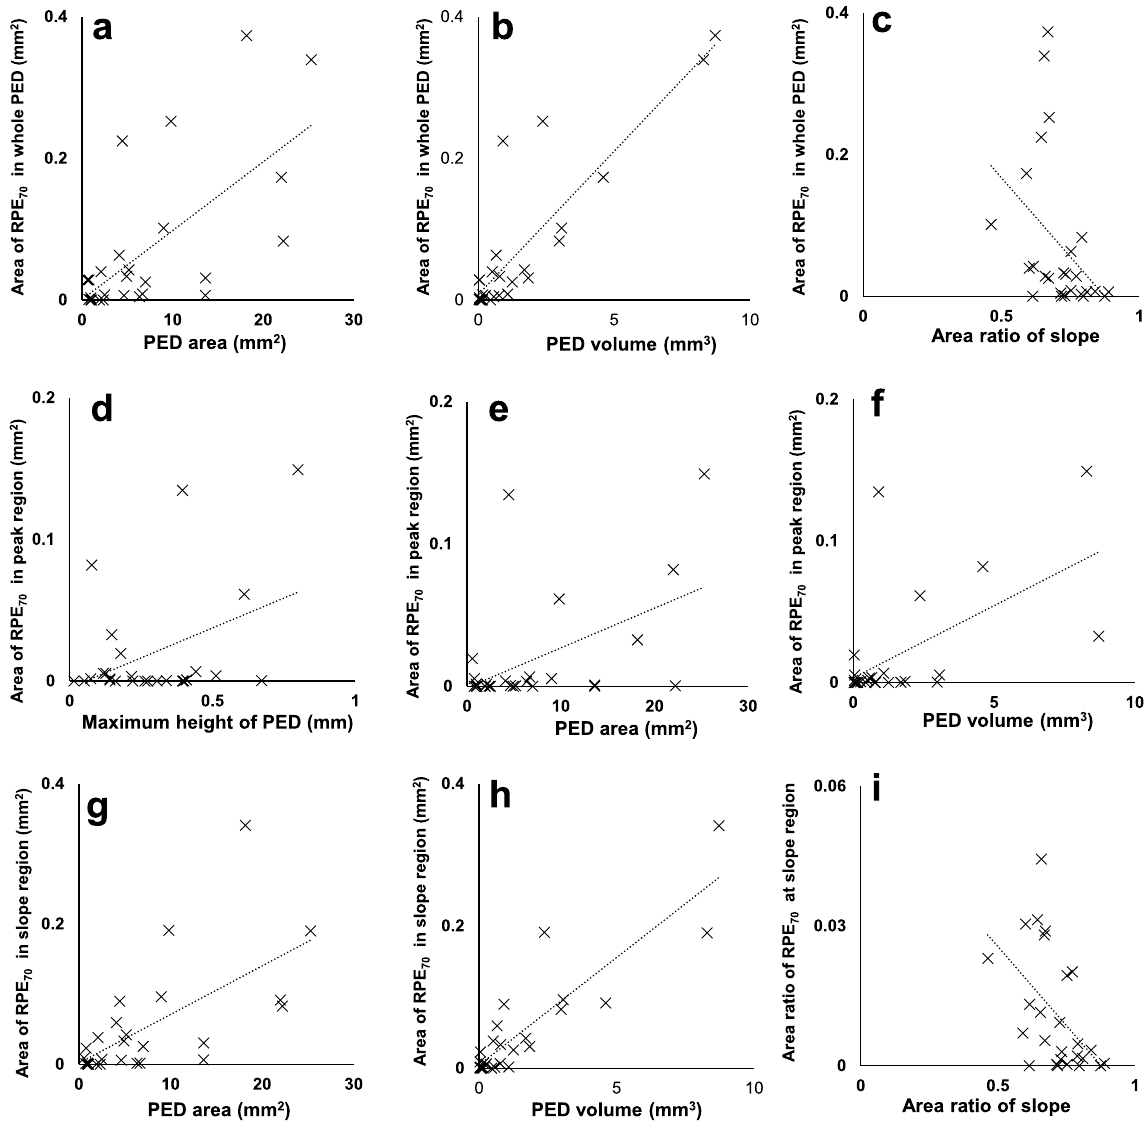
Figure 3. Scatterplots of RPE 70 areas or area ratios and morphometric PED parameters with statistically significant correlations. Scatterplots of the RPE 70 area for the whole PED as a function of ( a ) PED area, ( b ) PED volume, and ( c ) slope area ratio. Scatterplots of the RPE 70 area for the peak region as a function of ( d ) maximum PED height, ( e ) PED area, and ( f ) PED volume. Scatterplots of the RPE 70 area for the slope region as a function of ( g ) PED area and ( h ) PED volume. ( i ) Scatterplot of the RPE 70 area ratio for the slope region as a function of slope area